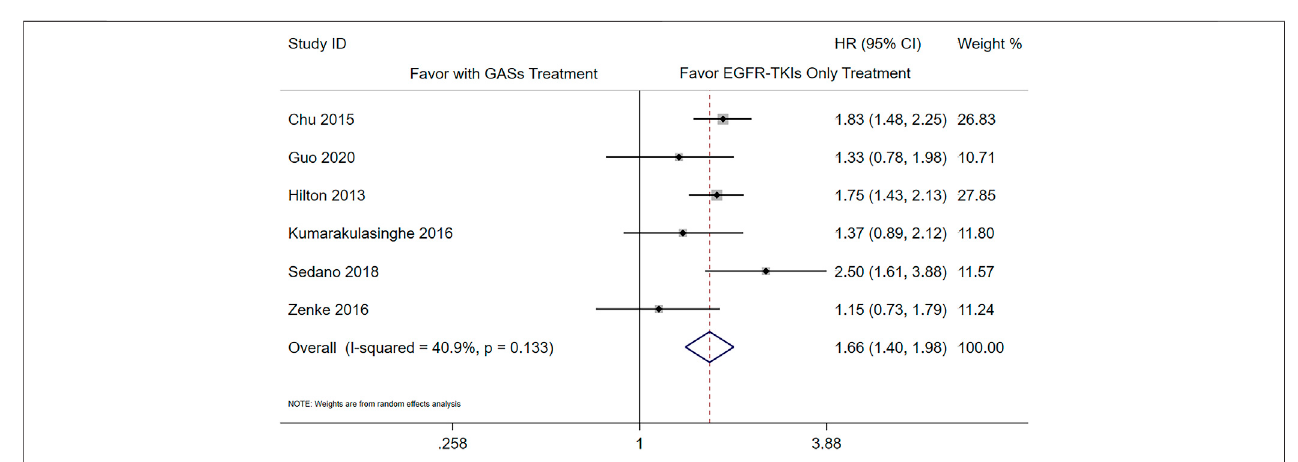
FIGURE 2 | In fl uence of the concomitant use of GASs on the PFS.